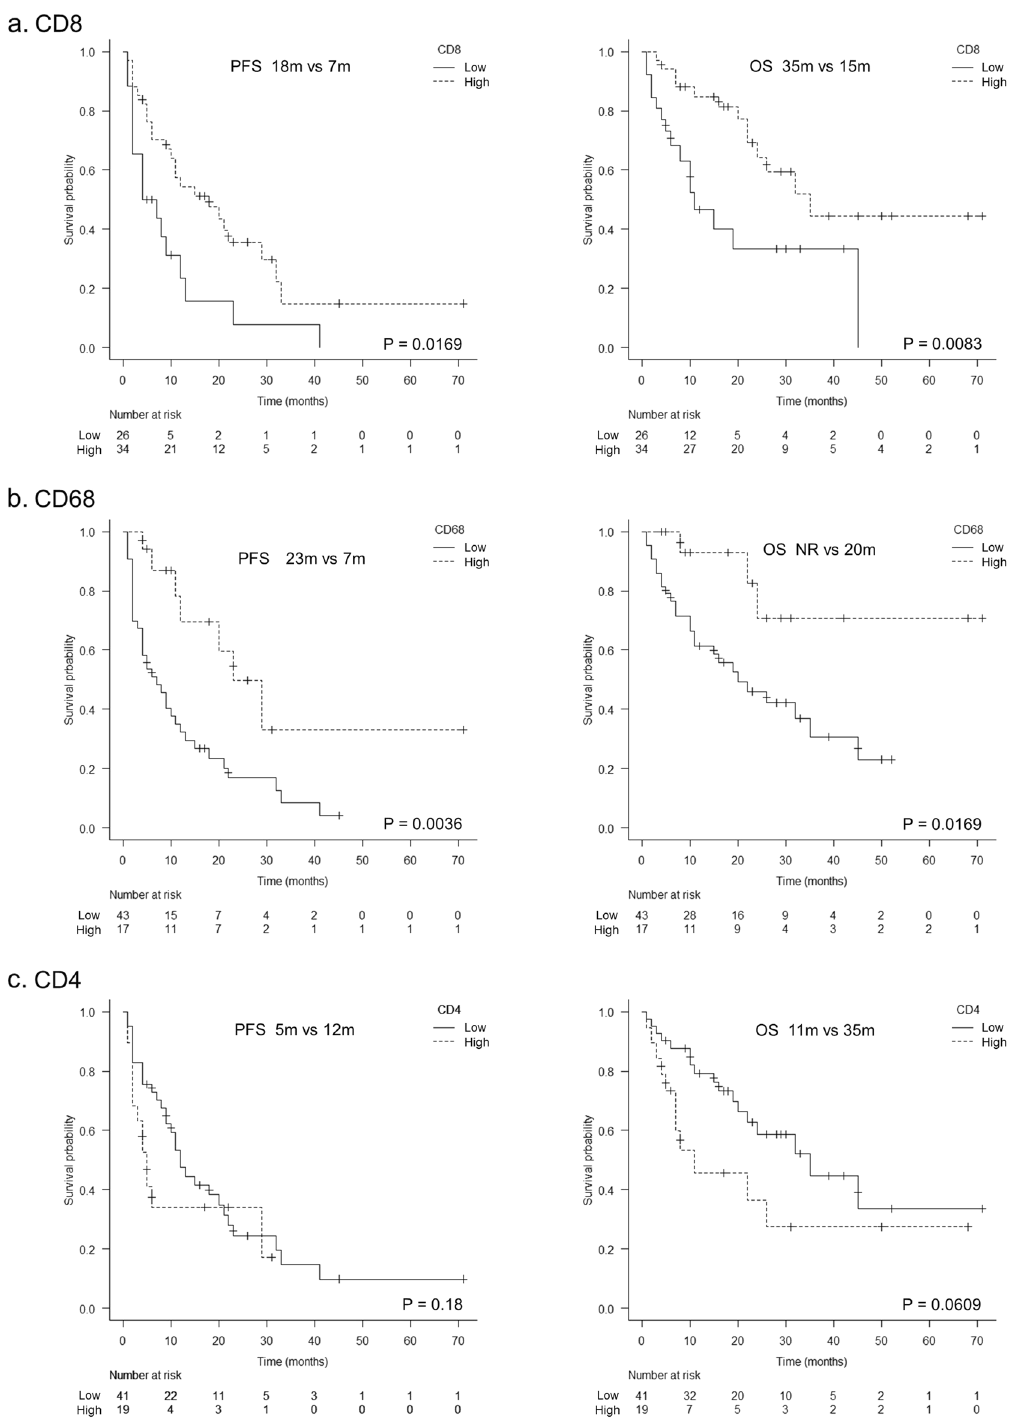
Figure 3. Kaplan–Meier plots of progression-free survival and overall survival stratified by IHC status of CD8, CD68, and CD4. ( a ) PFS and OS comparison by IHC staining of CD8 (log-rank P = 0.0169, P = 0.0083). ( b ) PFS and OS comparison stratified by IHC staining of CD68 (log-rank P = 0.0036, P = 0.0169). ( c ) PFS and OS comparison stratified by IHC staining of CD4 (log-rank P = 0.18, P =